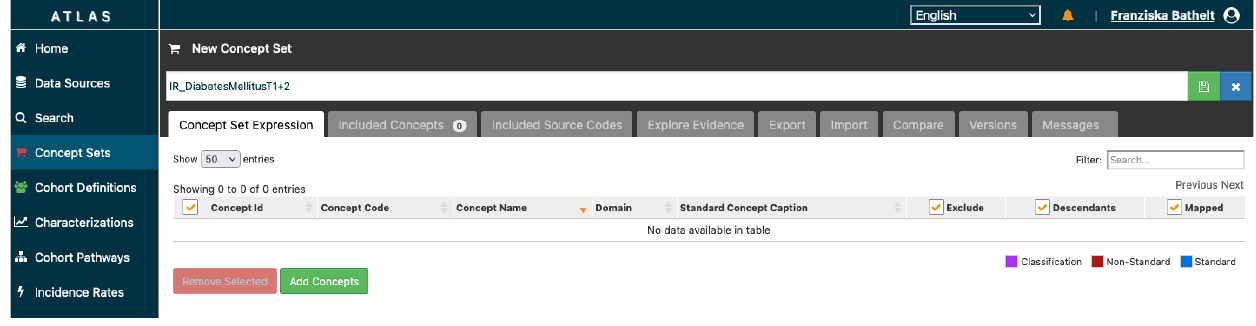
Figure A1. Interface of OHDSI ATLAS—Concept Sets.